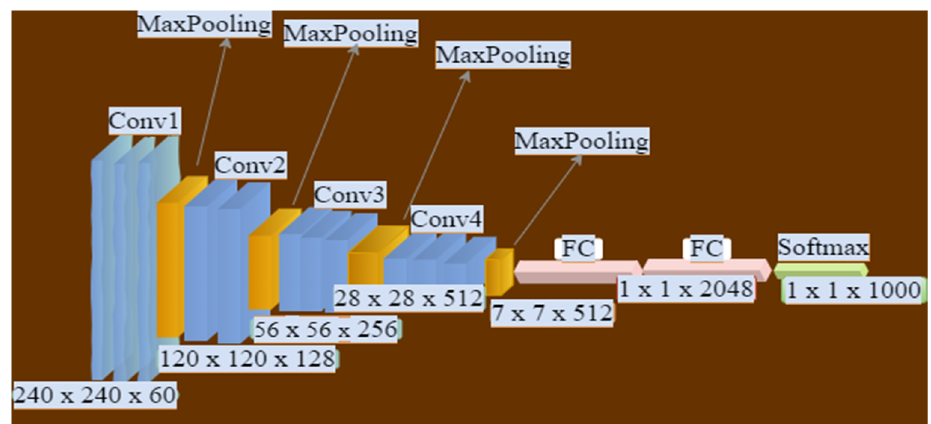
Figure 2. Overview of the CNN structure incorporated into HOG.